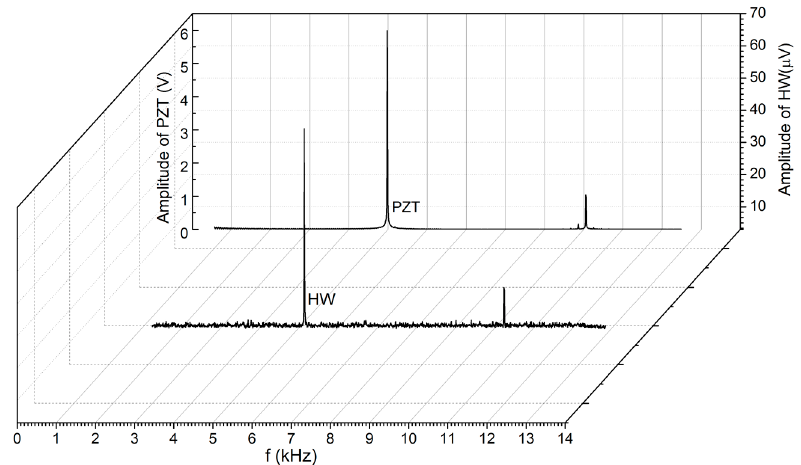
Figure 11. Frequency spectrum of output voltage on the hotwire and driving voltage on the PZT and the relationship between start-up time and different oscillating frequencies at various hotwire currents.